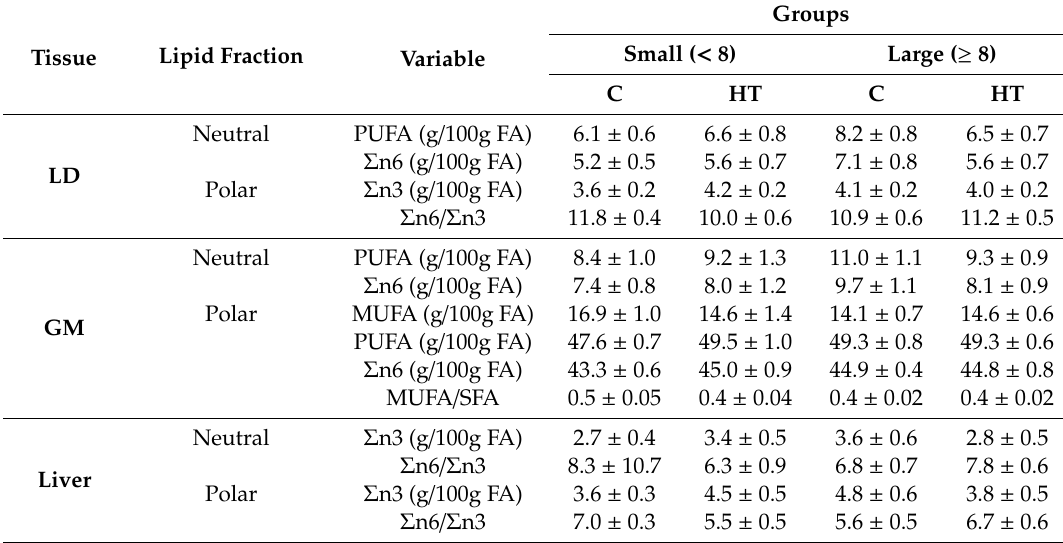
Group C: grupo control. Group HT: treated with hydroxytyrosol. LD = longissimus dorsi muscle, GM = gluteus medius muscle. FA = Fatty acids, SFA = sum of saturated fatty acids; MUFA = sum of monounsaturated fatty acids, PUFA = sum of polyunsaturated fatty